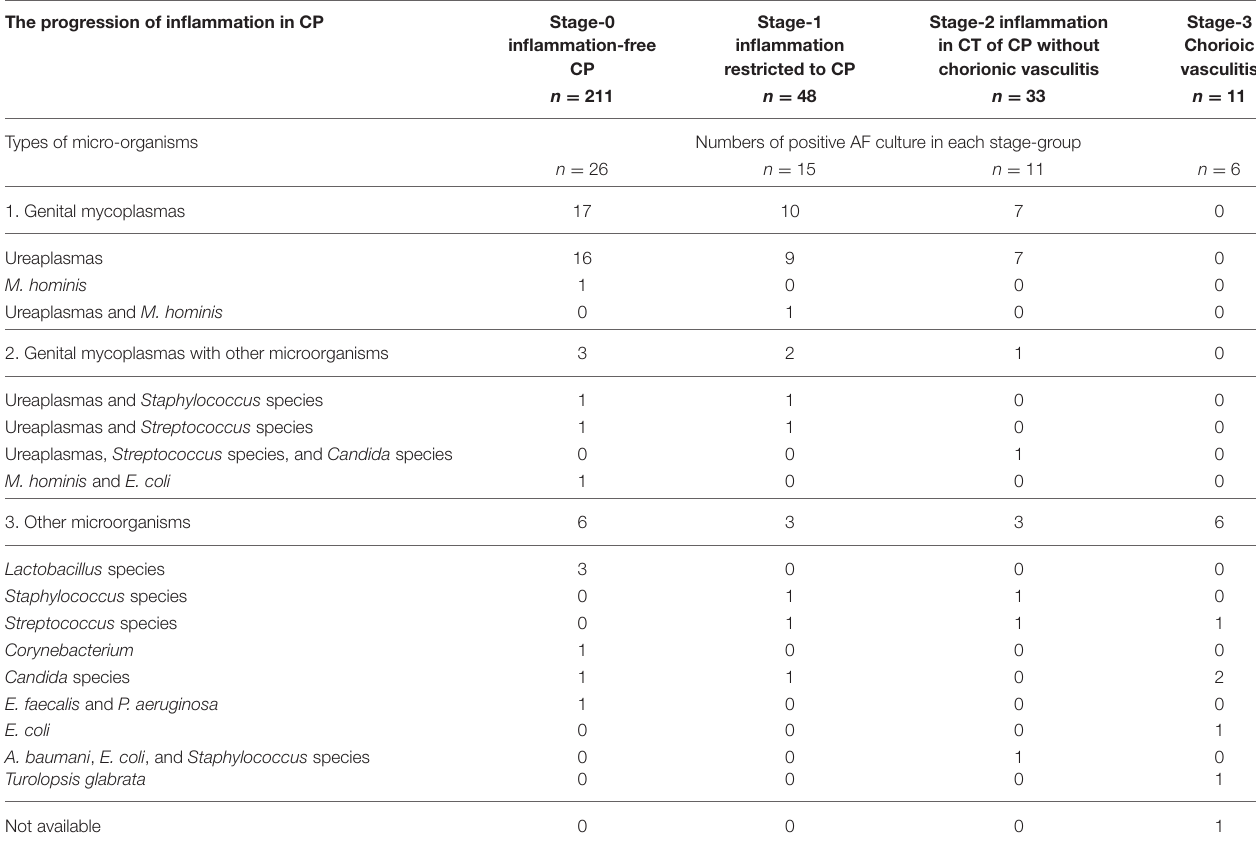
TABLE 3 | Types of microorganisms isolated from the amniotic fluid (AF) according to the progression of inflammation in the chorionic plate (CP) a . The progression of inflammation in CP Stage-0